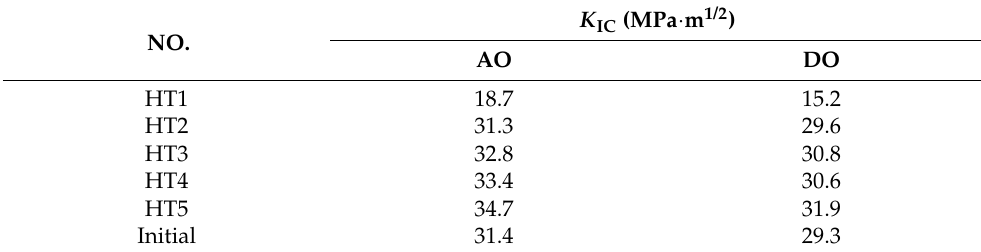
Table 3. Fracture toughness of the initial and heat-treated